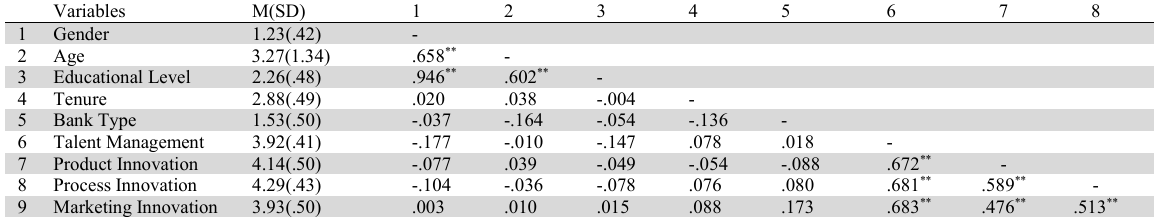
Correlations, means and standard deviations